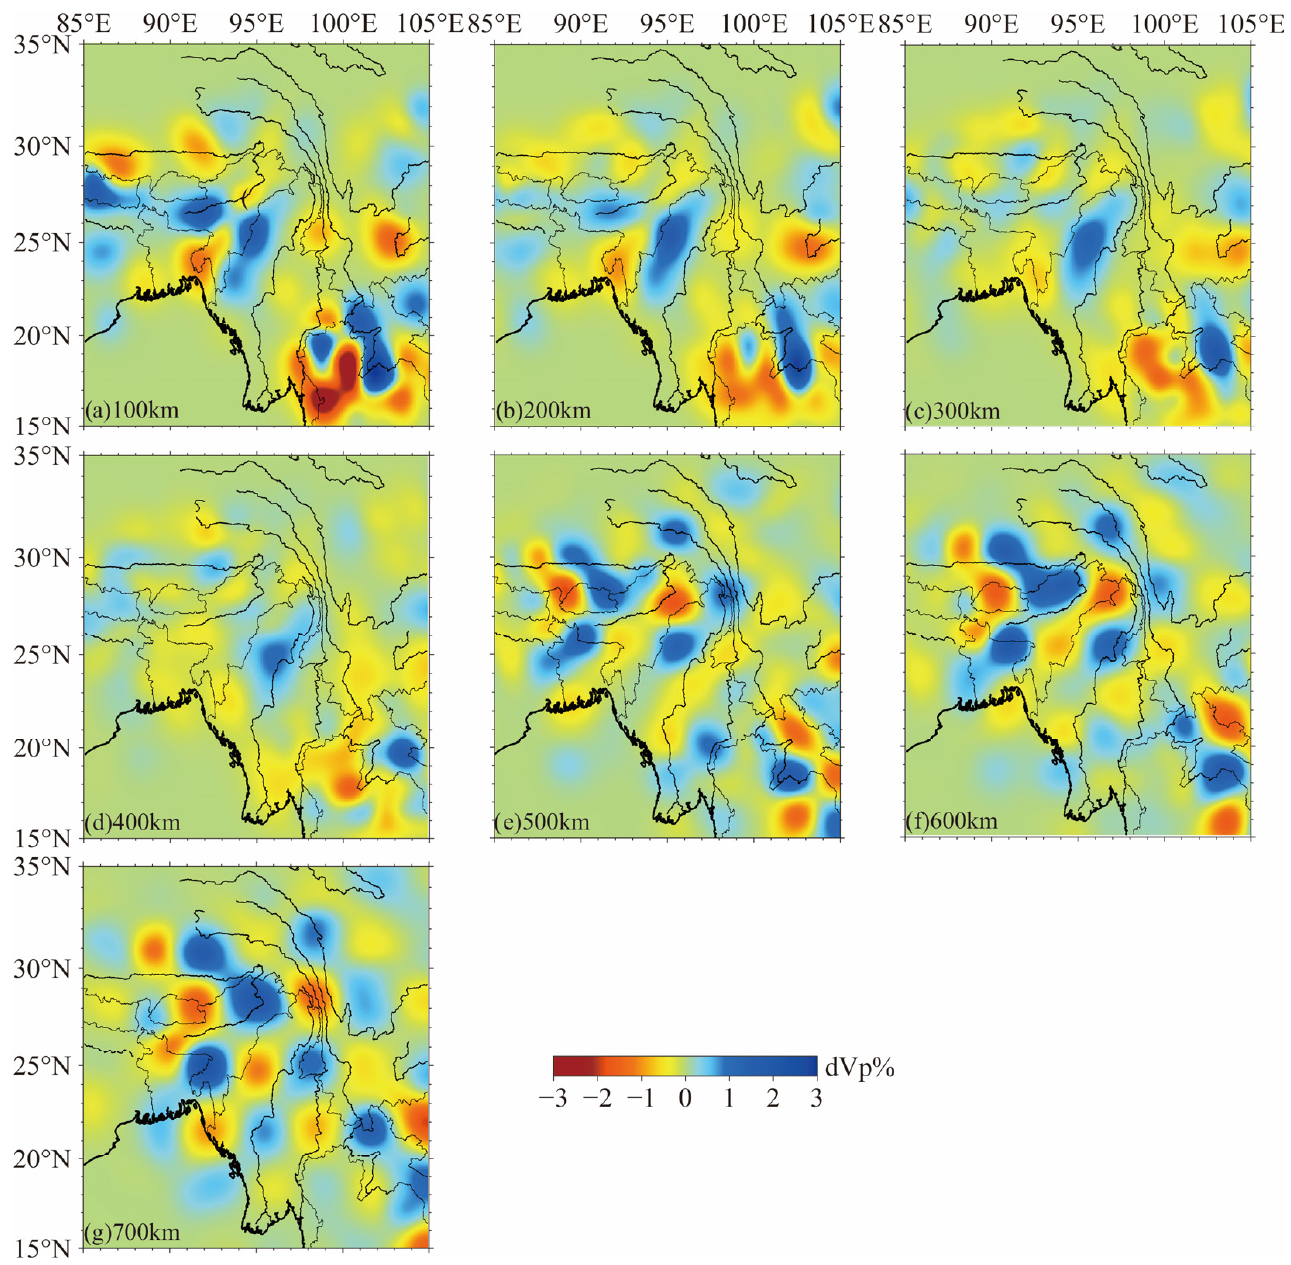
Figure 7. P-wave velocity tomography results ( a – g ) in Myanmar and the surrounding areas. The layer depth information is located at the bottom-left corner of the picture, and the velocity scale color scale is located at the middle bottom of the picture